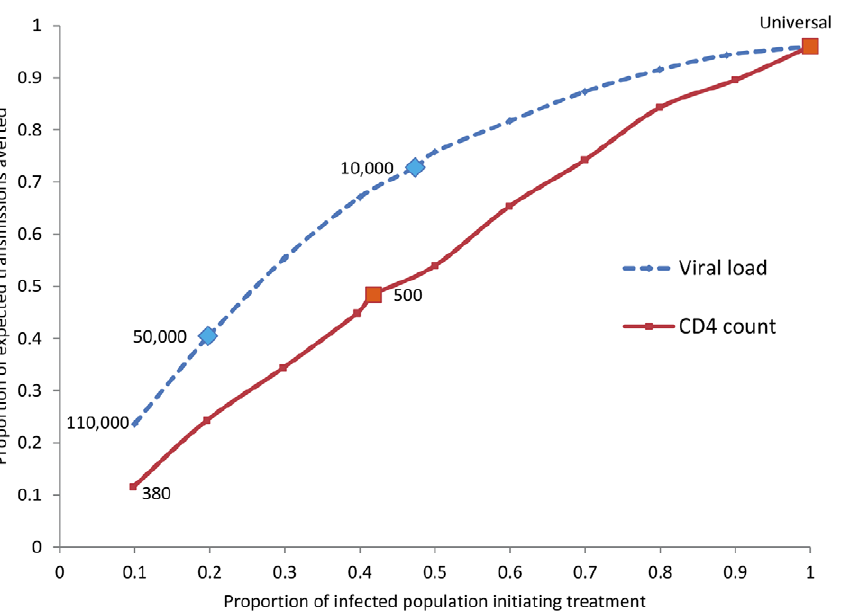
Figure 1. Proportion Initiating Treatment and Expected Transmissions Averted by Decreasing Viral Load and Increasing CD4 Count. The x-axis represents deciles of the population by decreasing viral load or increasing CD4 count; the y-axis represents the proportion of transmissions averted, assuming a 96% reduction in transmission on ART. Overall, the curve based on decreasing viral load begins steeply and later tapers, indicating at the highest viral loads the incremental proportion initiating treatment is small relative to the proportion of infections averted, reflecting the excess of transmissions that occur at high viral loads. The CD4 count curve, by comparison, is linear, suggesting that the prevention benefit associated with increasing the proportion on treatment differs little across CD4 counts in the . 350